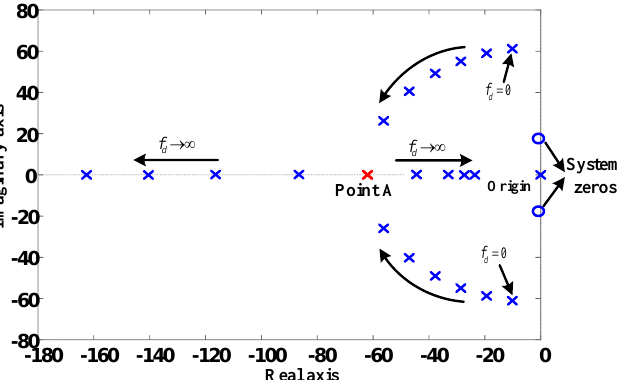
Figure 17. Zero-pole distribution diagram based on root locus.